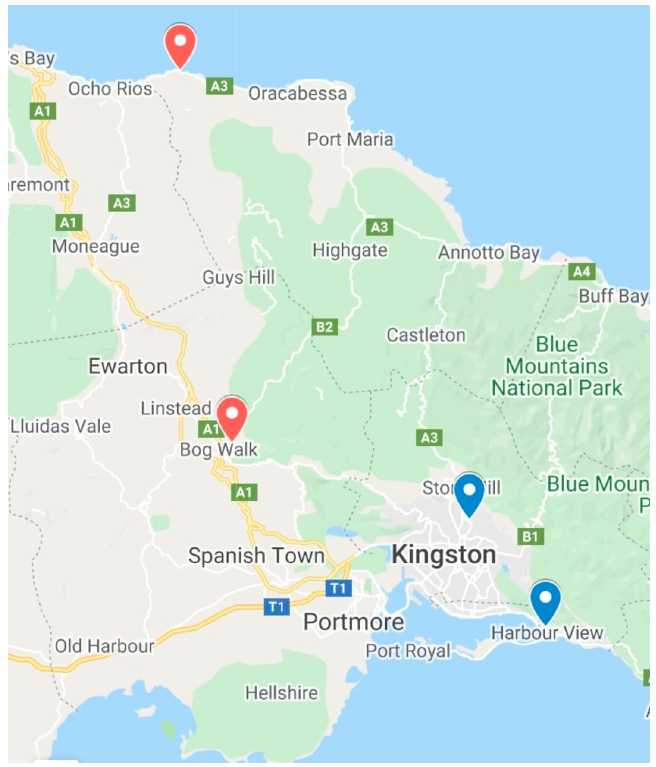
Figure 2. Map location of the schools in the